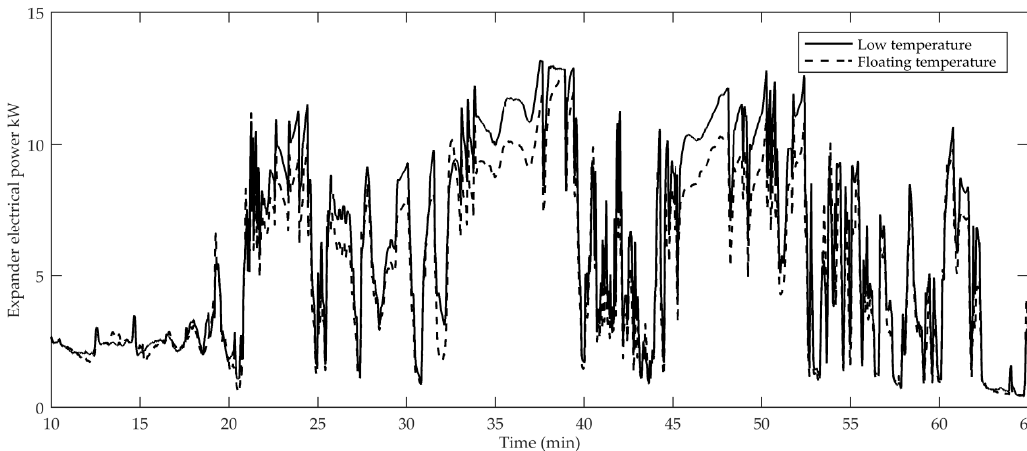
Figure 13. Expander power electrical, transient simulation result.